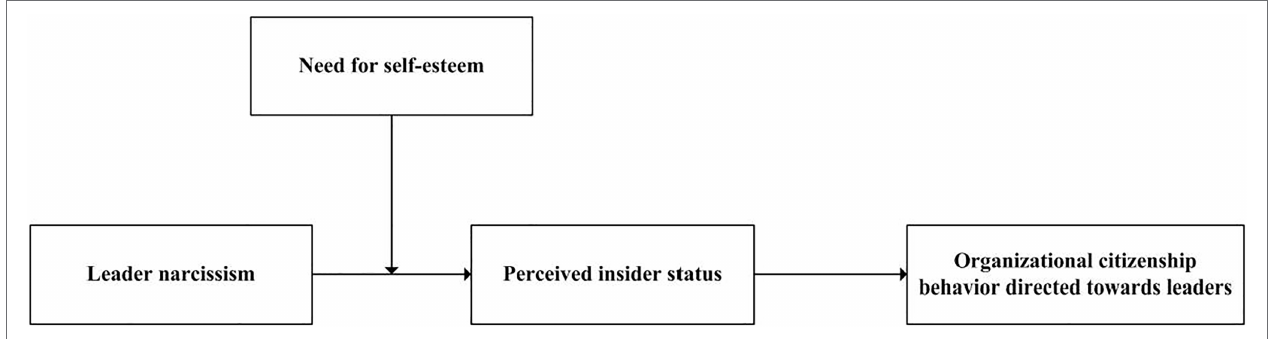
FIGURE 1 | Theoretical